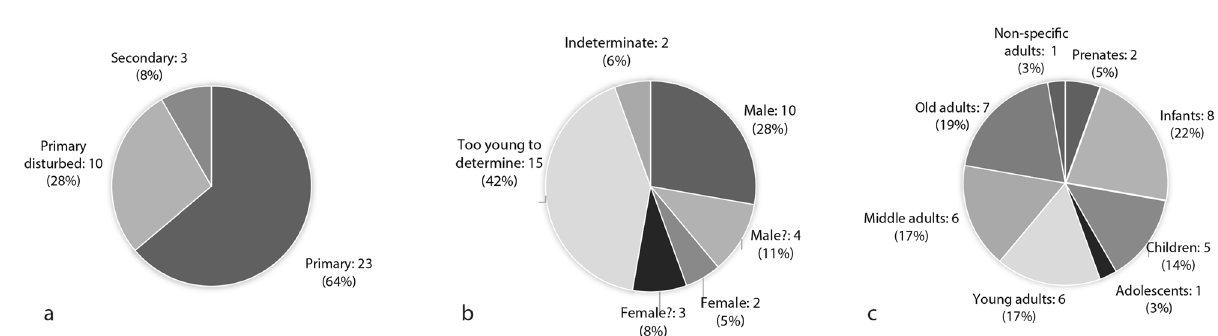
Figure 1. Distribution of Çatalhöyük human remains with direct pigment traces by ( a ) deposition category, ( b ) sex and ( c ) age-at-death. Charts generated with Microsoft Office Excel 2016 (https:// www. micro soft. com/ en- us/ micro soft- 365/